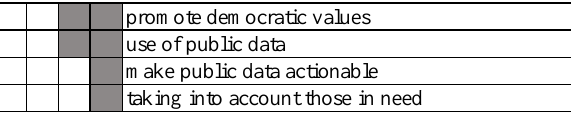
Table 3. Descriptors and their related profiles, with P1: techno- centric; P2: techno-social-centric; P3: socio-technical-centric; P4: social-centric. The dark grey cases represent a strong link between the descriptor and profile, the light grey cases represent an optional link, and the white cases represent no significant link